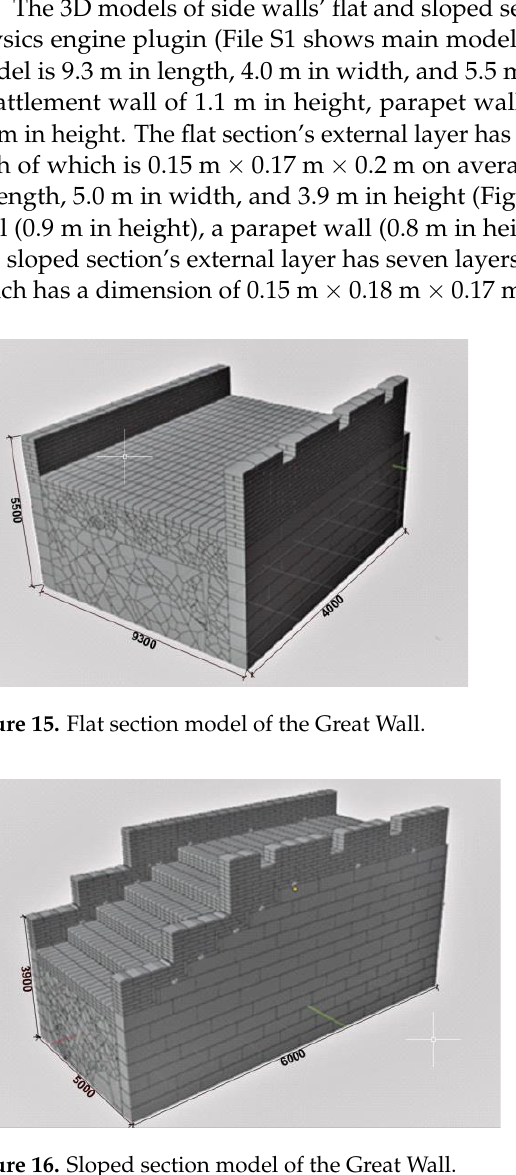
Figure 14. Load – displacement curves of the mortar joint friction tests.